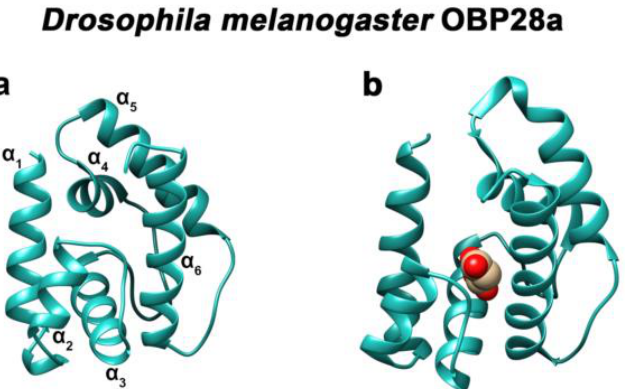
Figure 4. Three-dimensional structure of D. melanogaster OBP28a. ( a ) Apo- and ( b ) bound-three- dimensional structures of the fruit fly (Drosophila melanogaster) OBP28a (PDB: 6QQ4). α 1 to α 6 indicate the six α-helices found in the structure of classical insect OBPs. Drosophila OBP28a is in complex with penta-ethylene glycol [94].